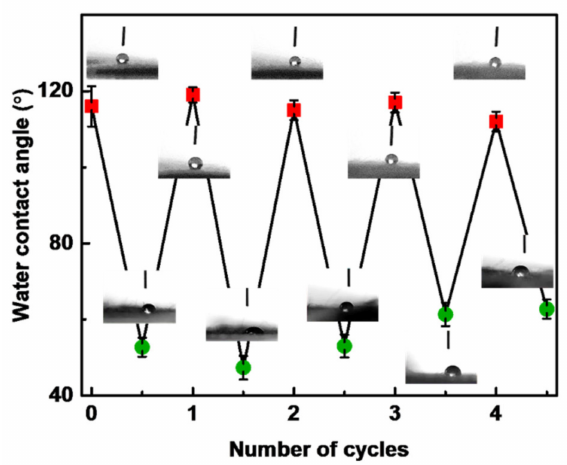
Figure 5. Reversibility of the WCA on the PNVCL-grafted cotton fabric after cycling the temperature between 37 and 20 ◦ C. Insets: Photographs of the water droplets at 37 ◦ C (red) and 20 ◦ C